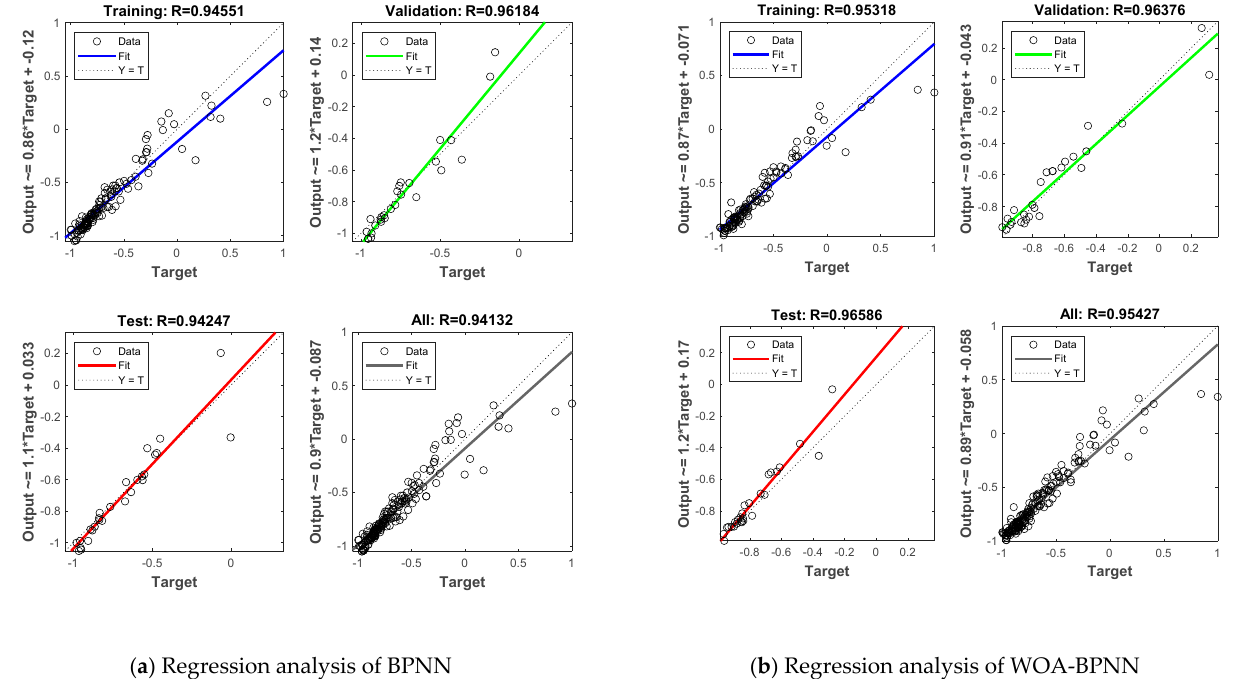
( b ) Regression analysis of WOA-BPNN